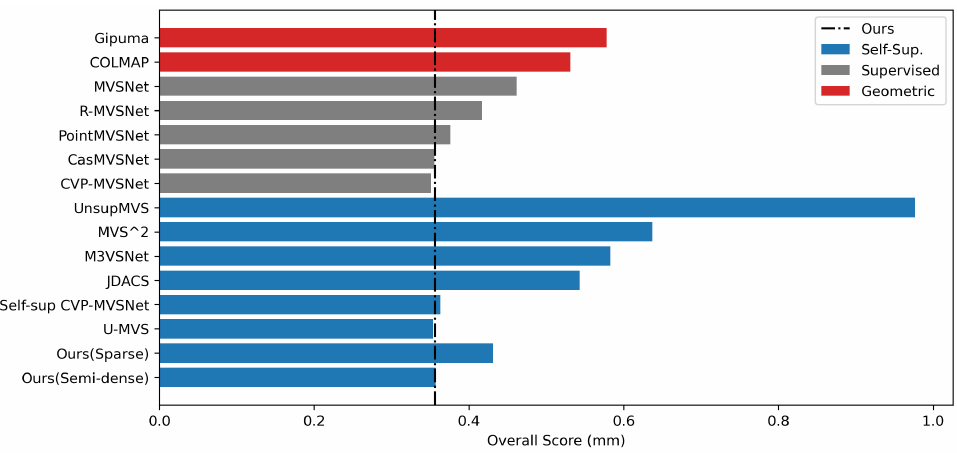
Figure 6. Comparison between SOTA MVS methods on DTU dataset (lower is